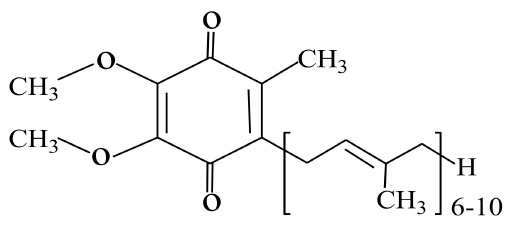
Figure 1. Chemical structure of coenzyme Q 10